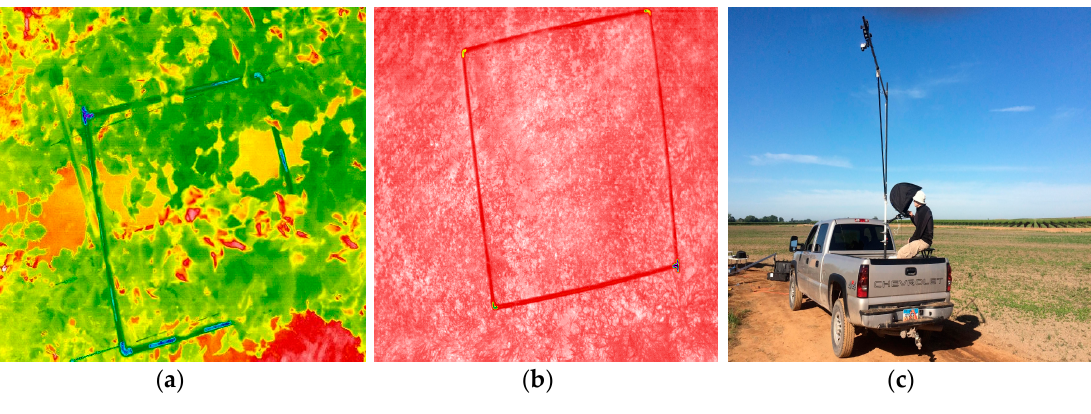
Figure 7. An example of ground temperature samples taken using the temperature camera mounted on a tripod (3 m height) and connected to a laptop loaded with ICI software IR FLASH on 3 May 2016, at Landsat overpass time. Temperature images of the top of vine canopy ( a ) and bare soil ( b ). Temperature camera and tripod mounted over a truck for fast ground temperature sampling ( c ).